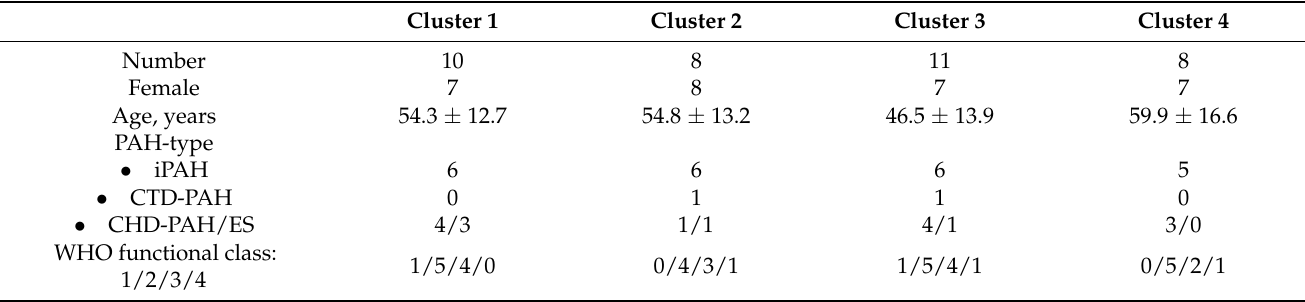
Table 2. Clinical characteristics of the subsequent